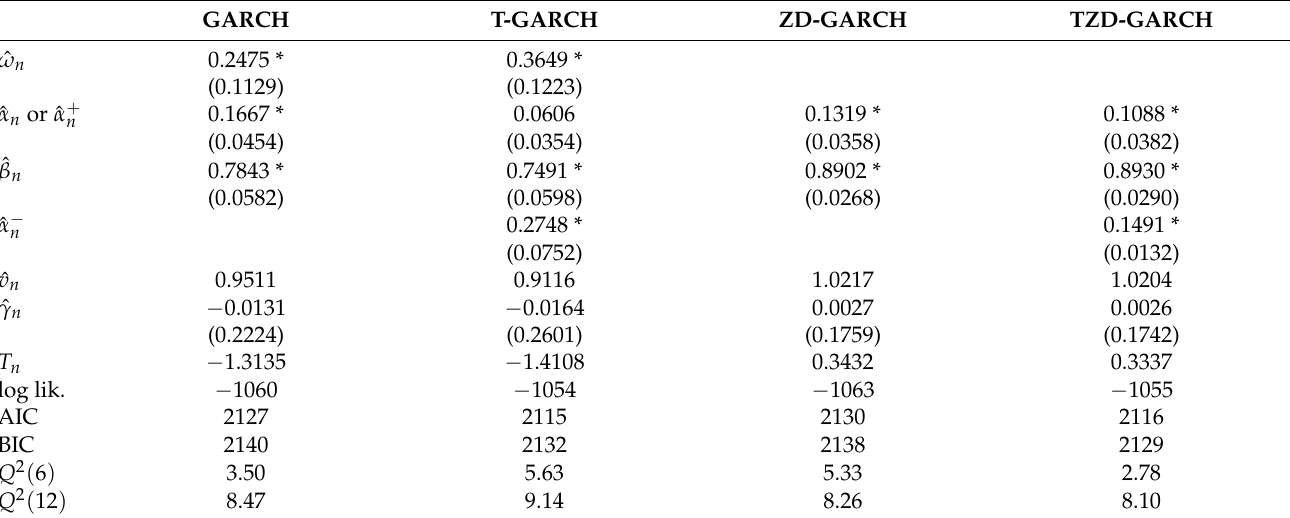
Table 2. Empirical results: